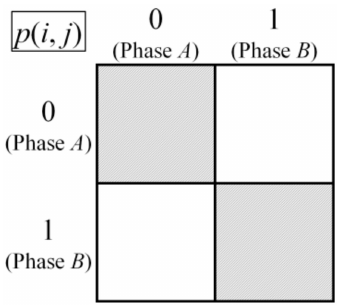
Figure 11. Conceptual image of the p ( i , j ) matrix in